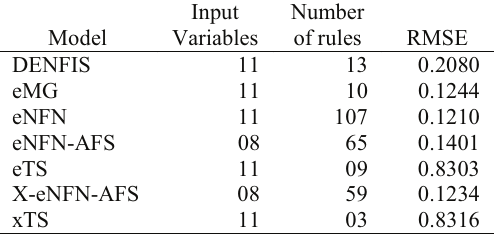
Table 3. Modeling performance for nonlinear system